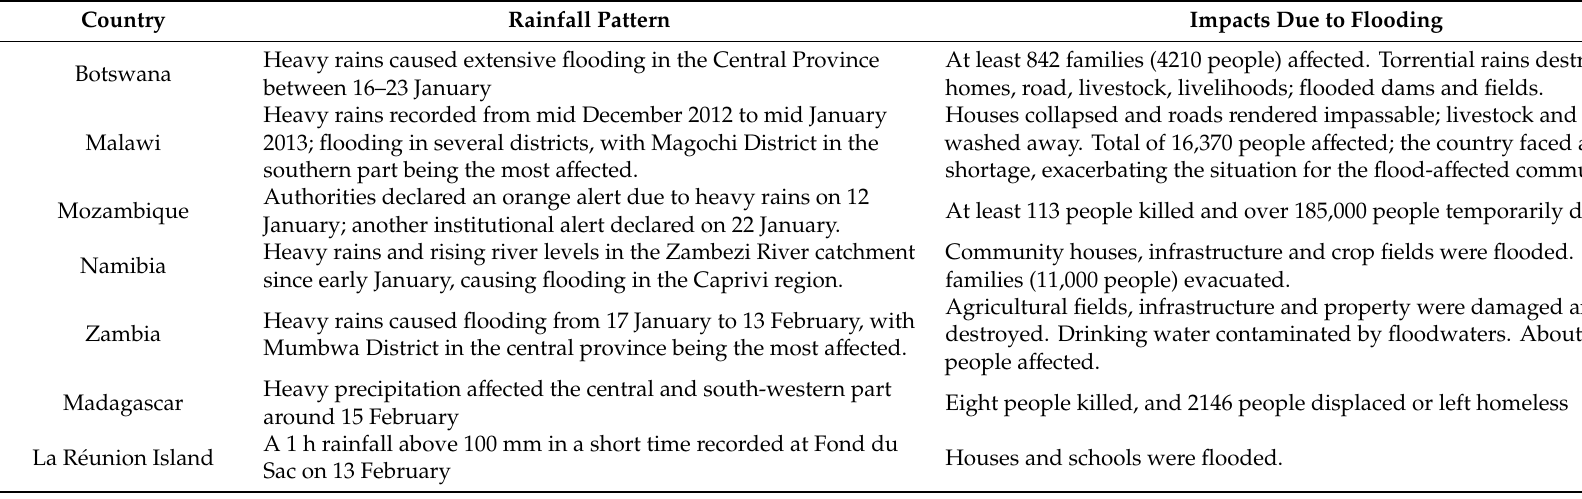
Table 1. Summary of the floods reported over southern Africa during 2013. (Source: WMO,